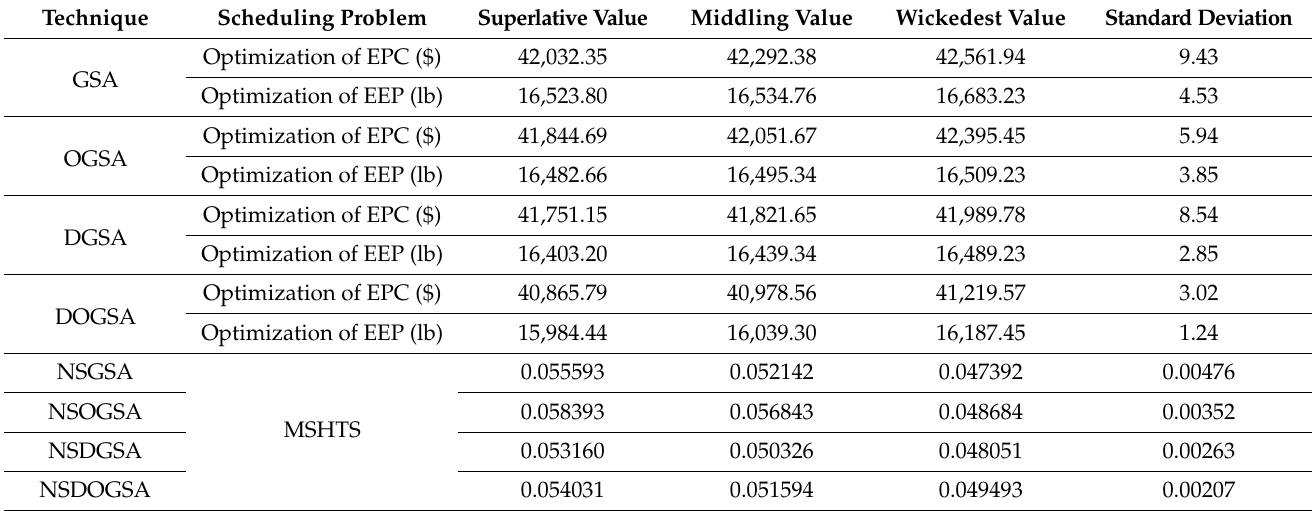
Table 11. Test System-I Statistical analysis with various approaches.